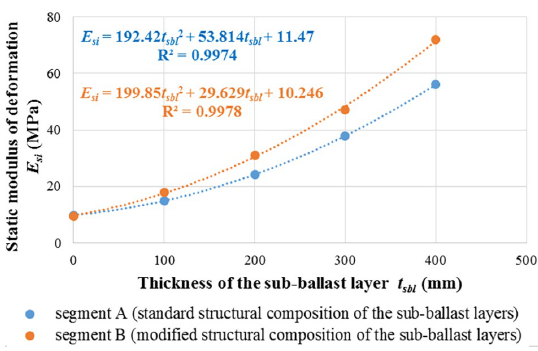
Figure 7. Comparison of standard ( Segment A – crushed aggregate only) and modified ( Segment B – crushed aggregate + 150 mm of foam glass aggregate) structural composition of the sub-ballast